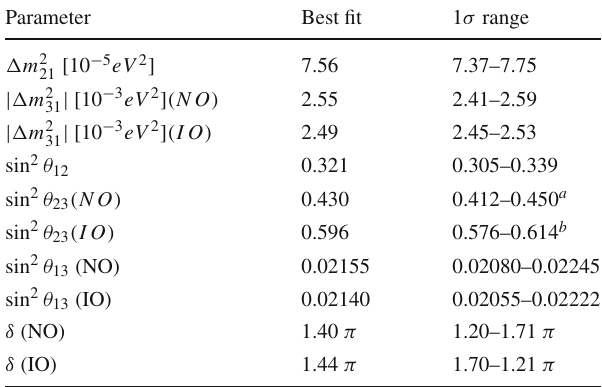
Table1 Neutrinooscillationparametersummaryfrom[37].For (cid:10) m 2 sin 2 θ 23 , sin 2 θ 13 , and δ the upper (lower) row corresponds to normal (inverted) neutrino mass hierarchy. a There is a local minimum in the second octant, at sin 2 θ 23 = 0 . 596 with (cid:10)χ 2 = 2 . 08 with respect to the global minimum. b There is a local minimum in the first octant, at sin 2 θ 23 = 0 . 426 with (cid:10)χ 2 = 1 . 68 with respect to the global minimum for IO